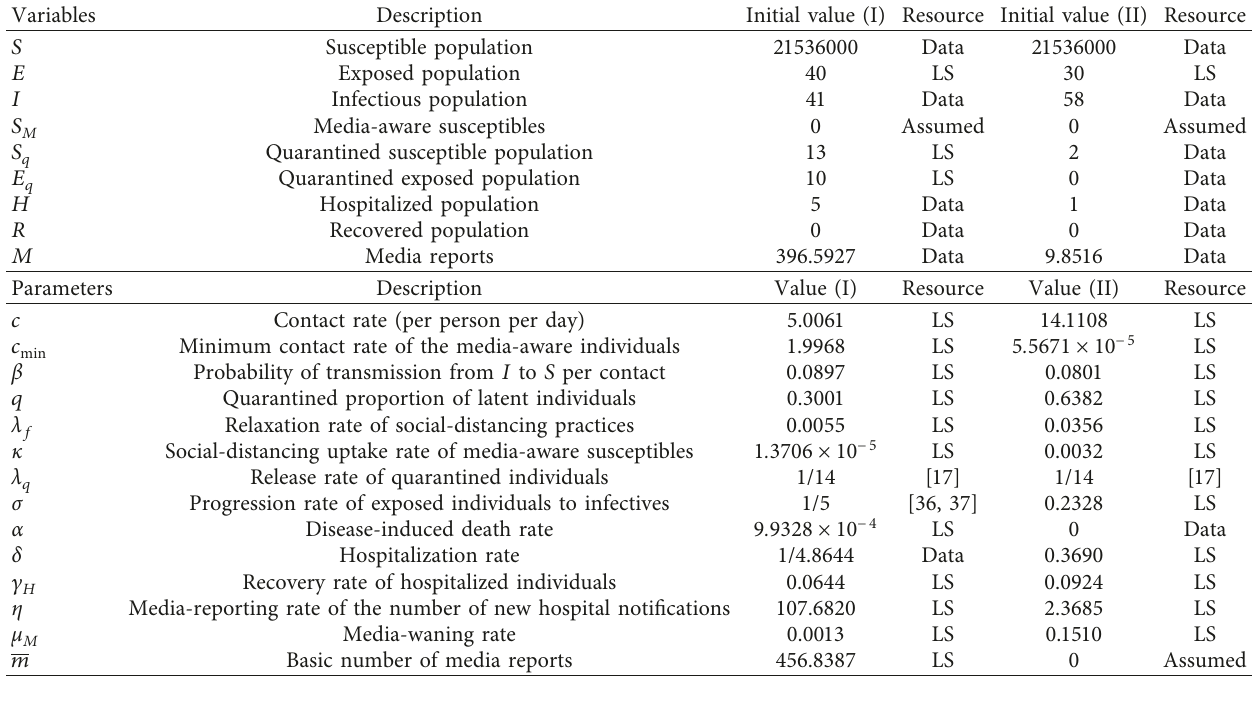
Table 1: Estimated initial values of variables and parameters for model (1). LS � least squares method. Variables